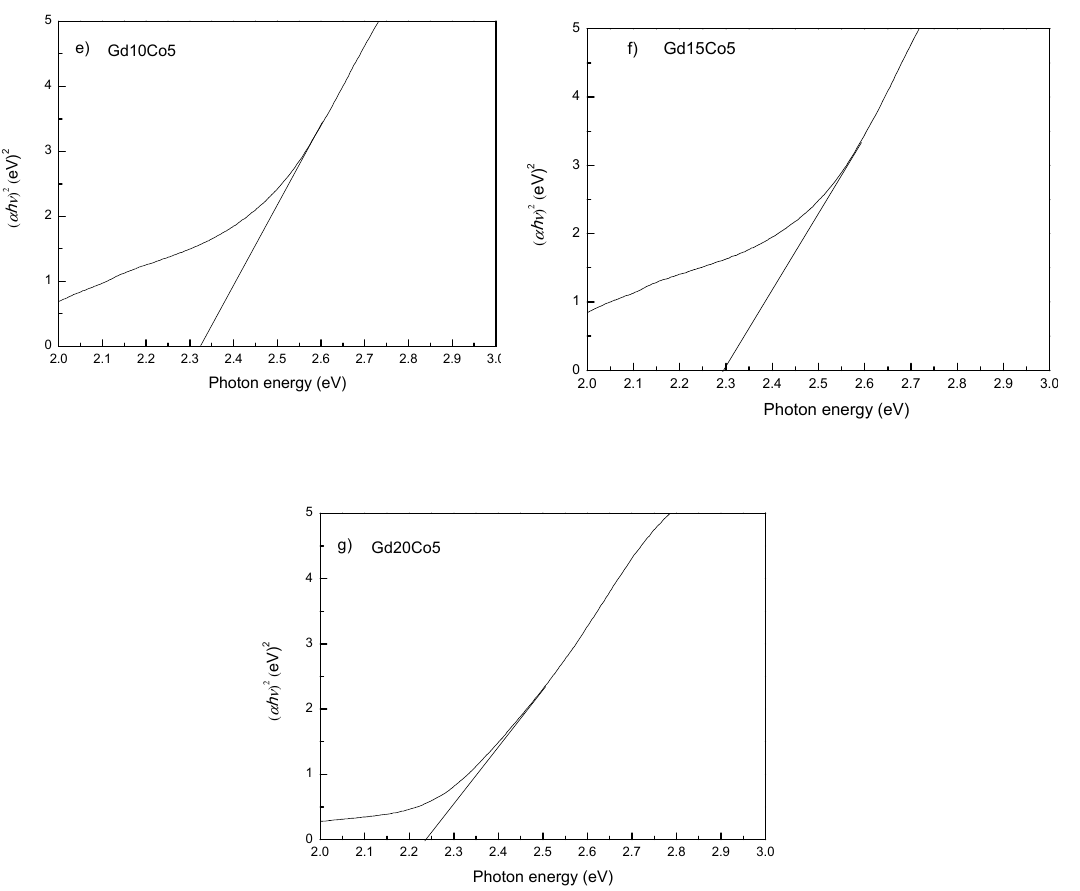
Figure 5. ( α h ν ) 2 as a function of photon energy for as-prepared nanoparticles: ( a ) YFO; ( b ) Co5; ( c ) Gd5; ( d ) Gd5Co5; ( e ) Gd10Co5; ( f ) Gd15Co5; ( g ) Gd20Co5.